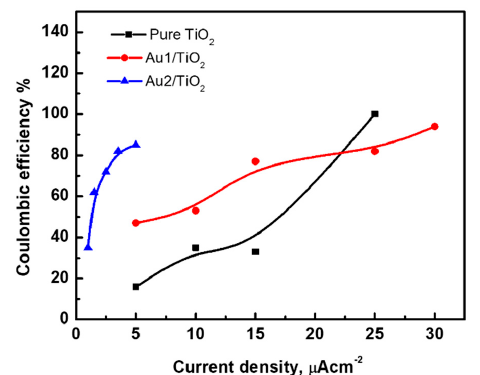
Figure 9. ( a ) Areal capacitance versus the voltage sweep rate and ( b ) areal capacitance versus the current density for pure TiO 2 , Au1/TiO 2 , and Au2/TiO 2 electrodes.